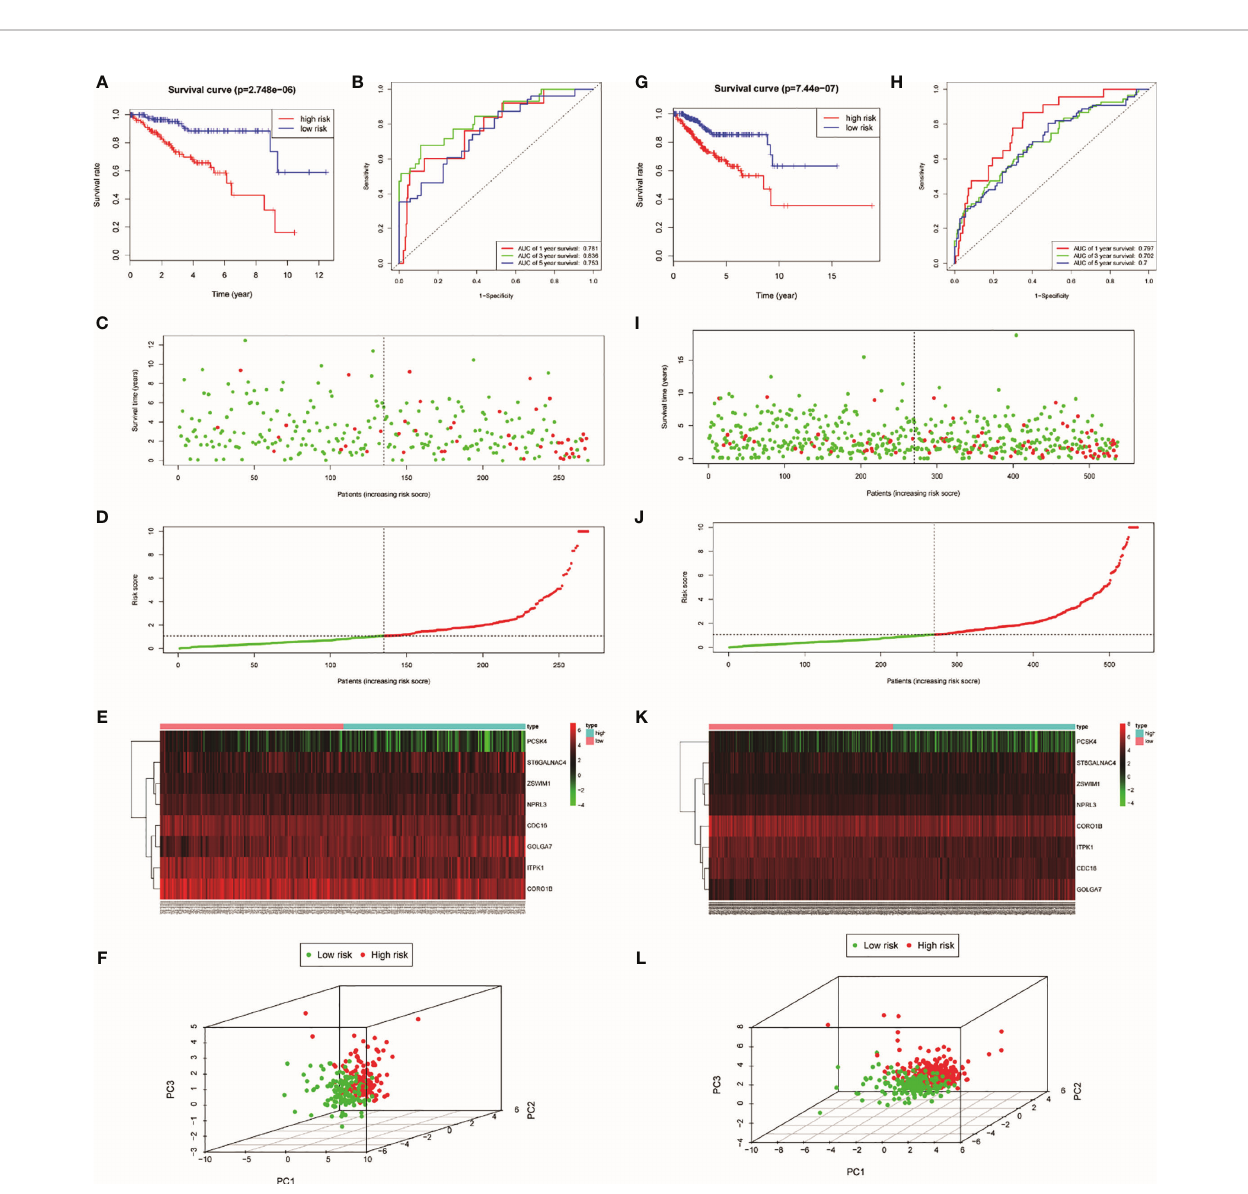
FIGURE 3 | Identi fi cation of TRRS in the train set (A – F) and the entire set (G – L) . (A, G) Kaplan – Meier curve analysis of overall survival of cervical cancer patients in high- and low-risk groups. (B, K) Time-dependent ROC curves analysis. Risk score distribution (C, I) , survival status (D, J) , and genes expression patterns (E, K) for patients in high- and low-risk groups by the TRRS. (F, L) Principal component